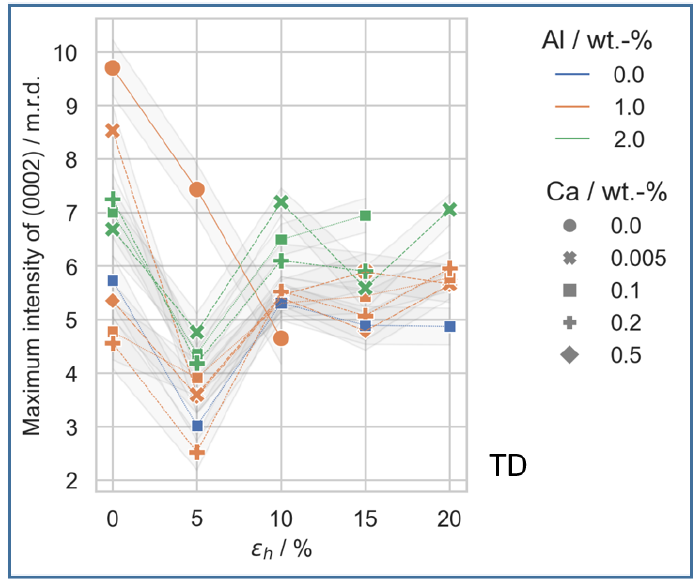
Figure 7. Maximum intensities of the basal (0002) peak for S_TD samples related to the relative height reduction ( ε h ) during cold rolling, including the absolute mean error resulting from the recalculation.